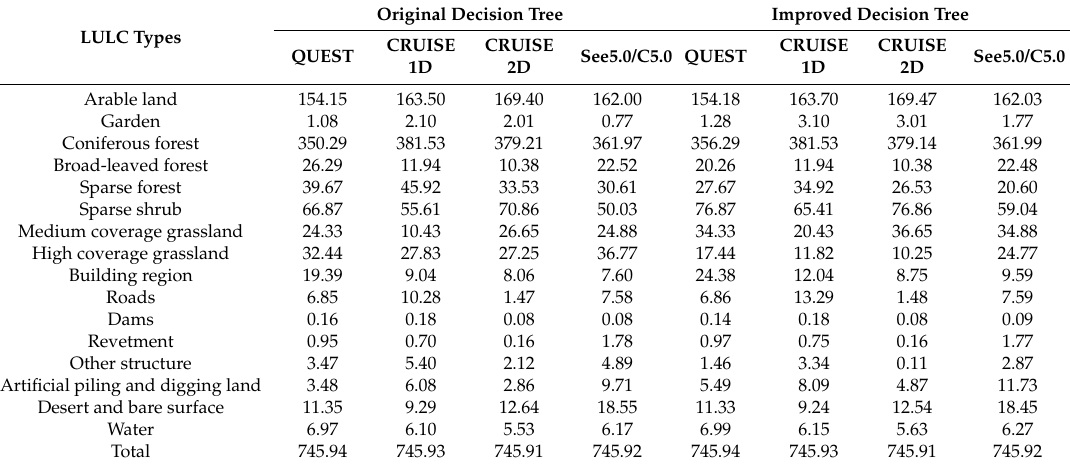
Table 9. Area comparison using the original and improved decision tree. Unit: (km 2 ).